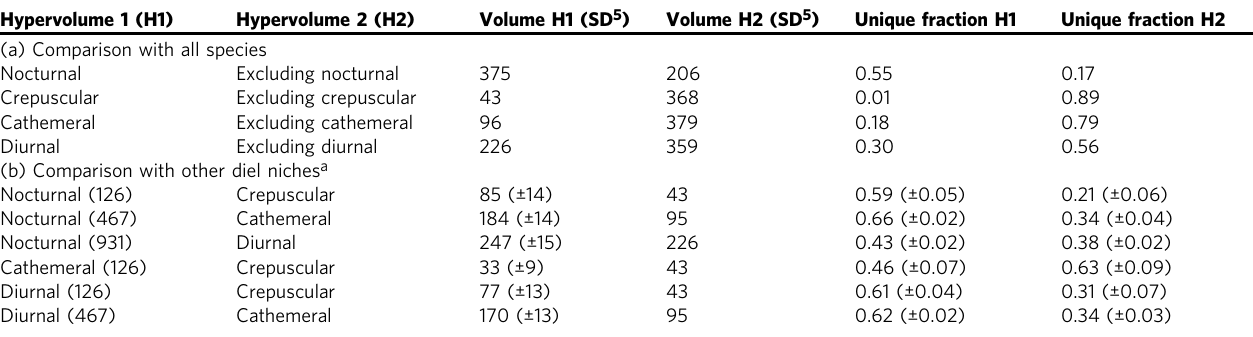
Table 1 Overlap in hypervolume estimation between mammals occupying different diel niches. Comparative paired analysis of each diel niche was carried out compared to (a) all species with other diel niches, and (b) species with each of the other diel niches in turn.